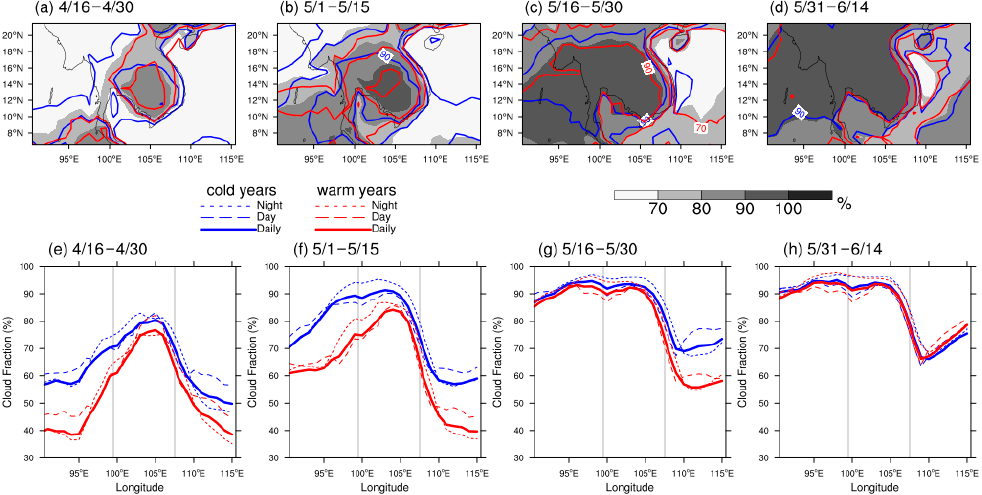
Figure 4. The seasonal variation of cloud fraction (CF) as revealed by averages of four 15-day periods from 16 April to 14 June. ( a – d ) The spatial distribution of climatological CF (shaded) and composited CF for warm years (red contour) and cold years (blue contour). The CF is a dimensionless quantity and is expressed as a percentage here. The contour interval is 10%; with the first contour at 70%. The plots were derived from daily CF. ( e – h ) The longitudinal distribution is of composited CF for warm years (red lines) and cold years (blue lines). The daily, daytime, and nighttime CFs are shown. The longitudinal values were obtained by averages from 10.5 ◦ N to 18.5 ◦ N. The vertical gray lines indicate the western and eastern bounds of the ICP. From left to right panels, the 15-day periods are 16 April to 30 April, 1 May to 15 May, 15 May to 30 May, and 31 May to 14 June, respectively. The vertical distribution of clouds is further examined using the joint histograms of cloud optical properties COT and CER, respectively, against the CTP. Here we followed the COT/CTP-based cloud classification defined in the ISCCP [41] with marginal modification. According to the ISCCP cloud classification, clouds are grouped into three cloud-top regimes: high clouds with CTP < 440 hPa, middle clouds with 440 hPa ≤ CTP< 680 hPa, and low clouds with CTP ≥ 680 hPa. Every cloud-top regime is further classified into three categories of thin, moderate, and thick optical thicknesses, respectively, using the COT thresholds of below 3.6, between 3.6 and 23, and above 23. The ISCCP cloud classification is used for classifying nine optical cloud types with respect to the morphological cloud types. From low to middle and high cloud regimes, those of thin optical thicknesses are cumulus, altocumulus, and cirrus, those of moderate optical thicknesses are stratocumulus, altostratus, and cirrostratus, and those of thick optical thicknesses are stratus, nimbostratus, and deep convection. The joint histogram bins of COT against CTP in the MODIS